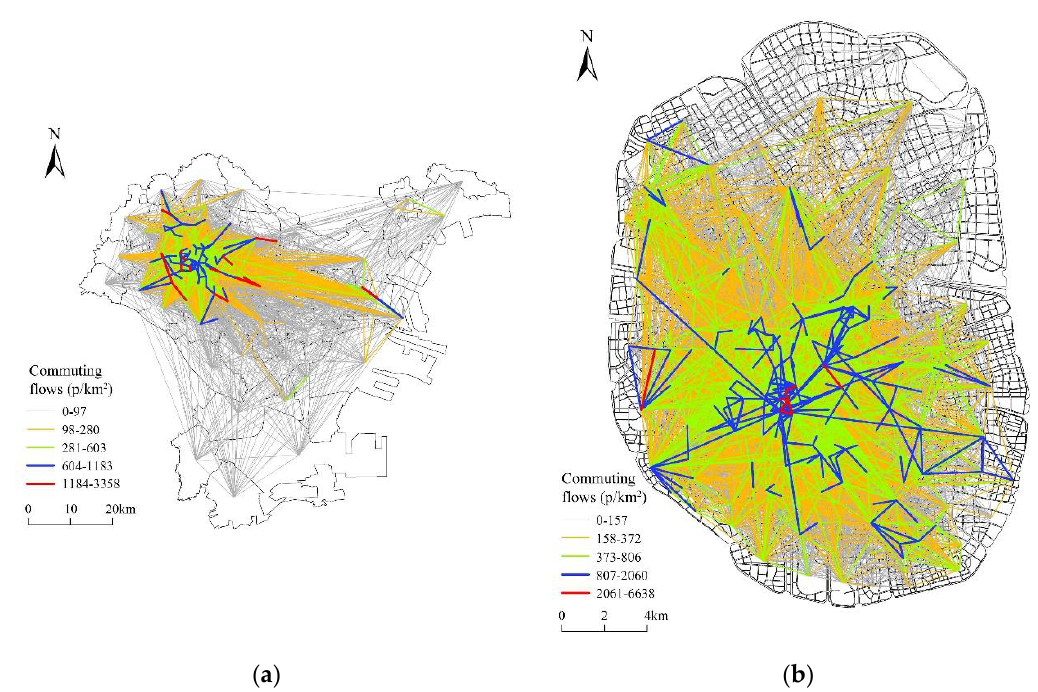
Figure 4. ( a ) Commuting flows in Tianjin metropolitan area; ( b ) Commuting flows in Tianjin central area.